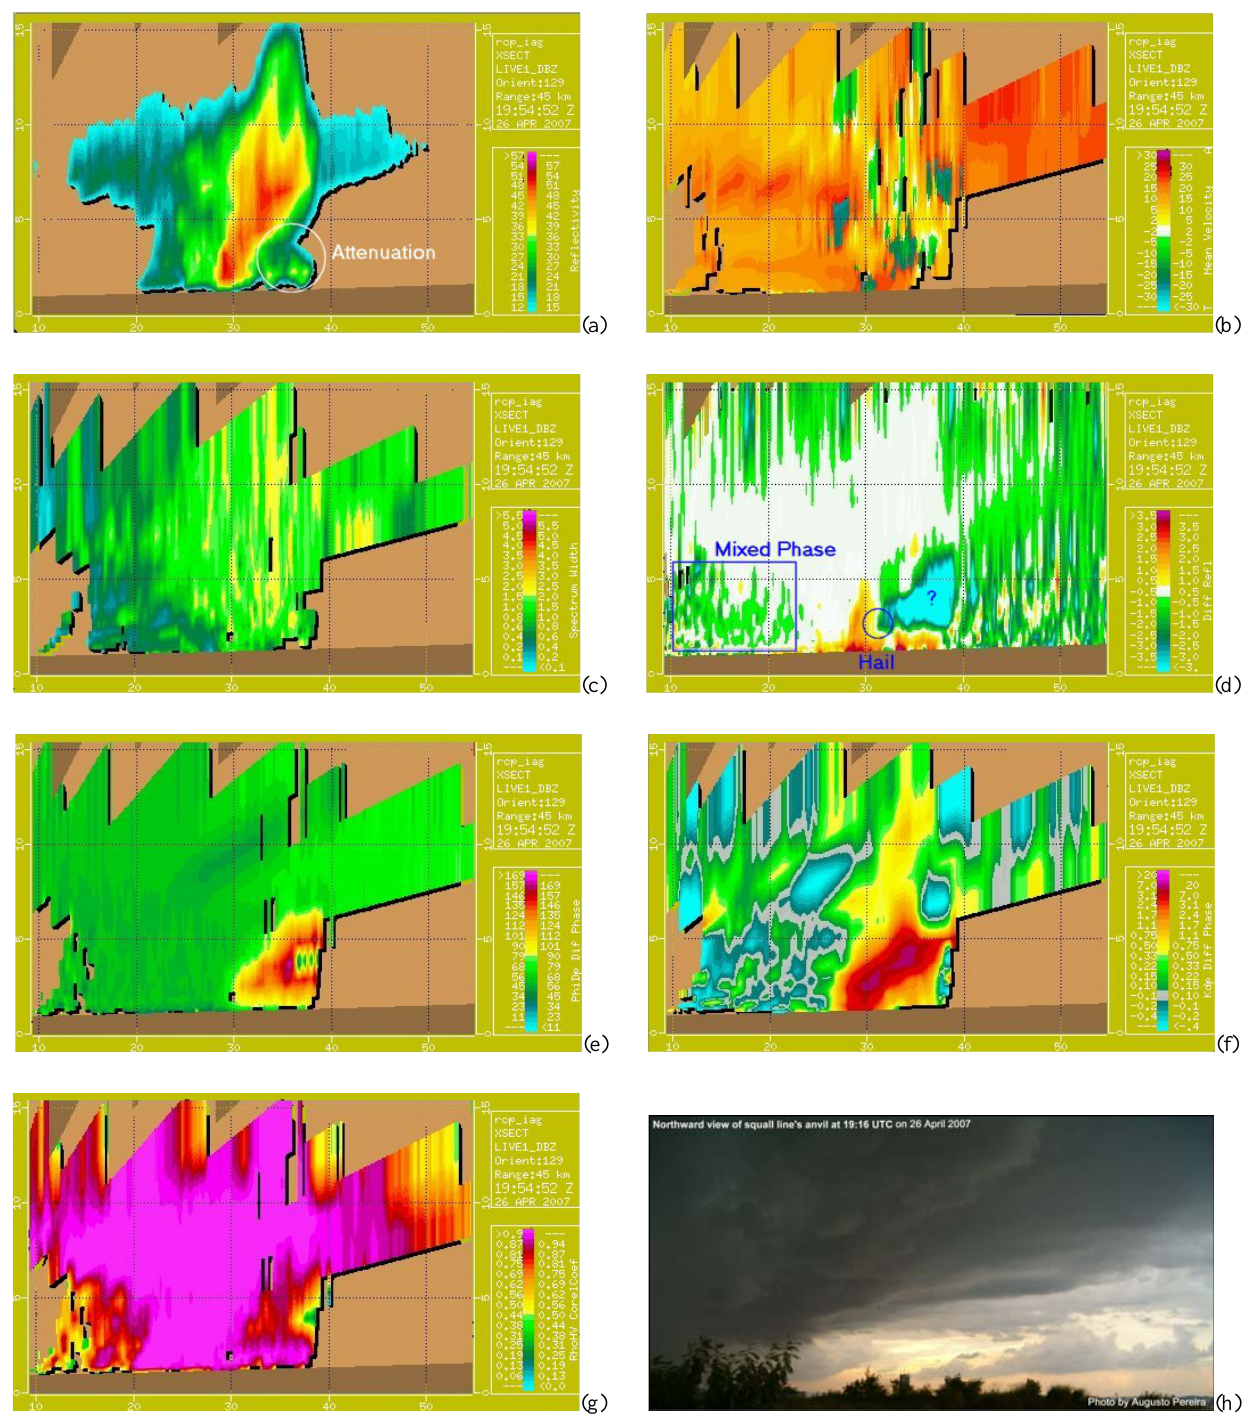
Fig. 10. NW–SE cross-sections of reflectivity – Z (a) dBZ, radial velocity – V (b) ms − 1 , spectral width – SW (c) ms − 1 , differential reflectivity – Z DR (d) , differential propagation phase – ϕ DP (e) degree, specific differential phase – K DP (f) degree km − 1 and correlation coefficient VH – ρ oHV (g) obtained with MXPOL at 19:54UTC on 26 April 2007. Colour scales are indicated in each cross-section. The photo of the anvil of the squall line ( h ) was taken looking Northward from MXPOL site at 19:16UTC on 26 April